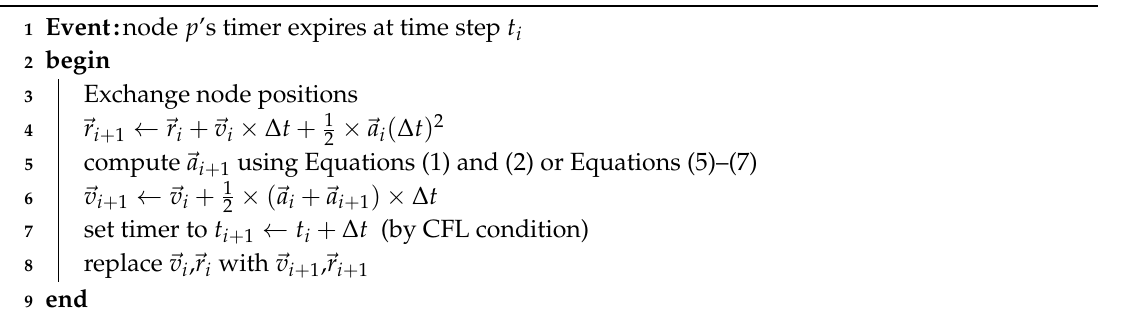
Algorithm 1 Distributed algorithms in VFA-DP and VFA-LJ in wireless sensor